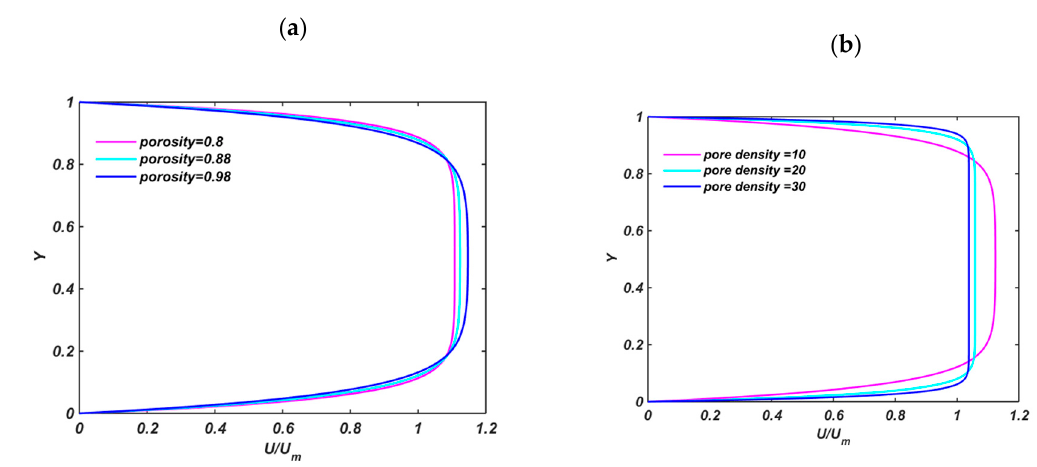
Figure 5. E ff ect of ( a ) porosity and ( b ) pore density on velocity Figure 5. Effect of ( a ) porosity and ( b ) pore density on velocity profile.